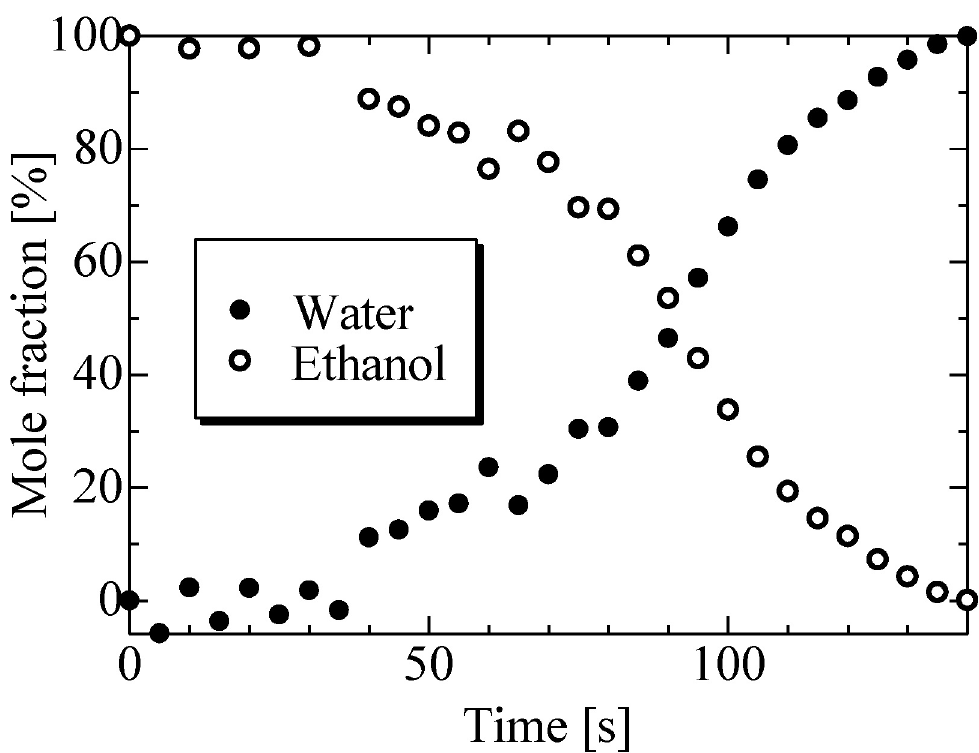
Fig 11. Evolution of ethanol droplet composition with